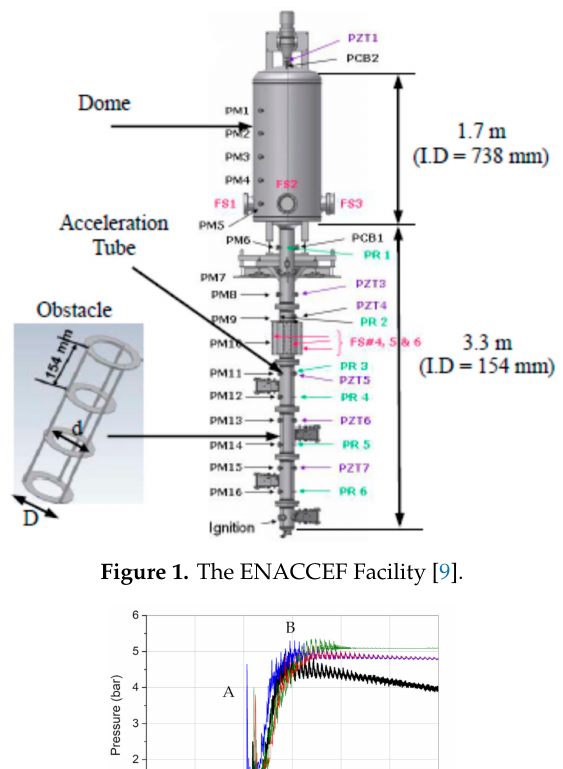
Figure 1. The ENACCEF Facility [9].